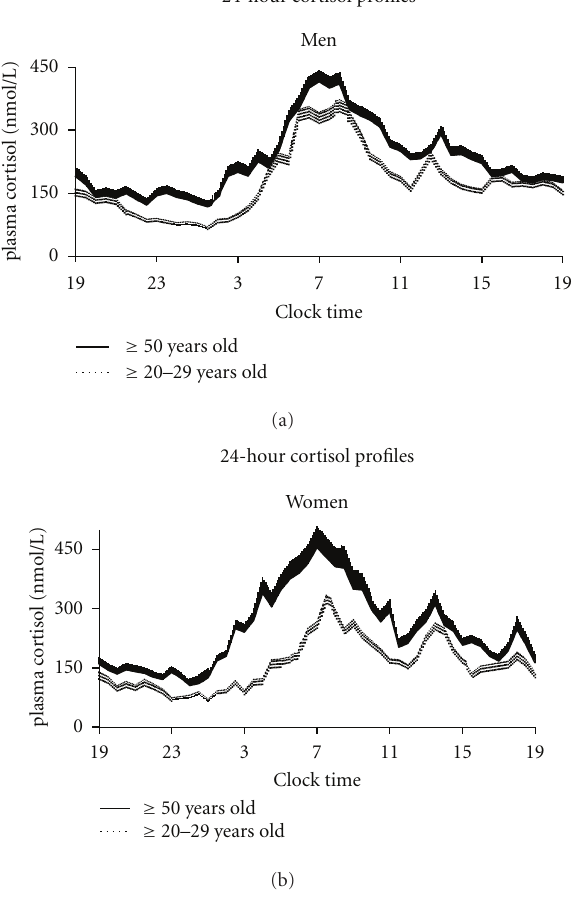
Figure 2: E ff ects of age and sex on cortisol profile: Mean 24-hour (+ or − SEM) cortisol profiles in men (left profiles) and women (right profiles) for 2 age groups that is, 50 years of age and older (solid lines) and 20 to 29 years old (hatched lines). (adapted from Van Cauter